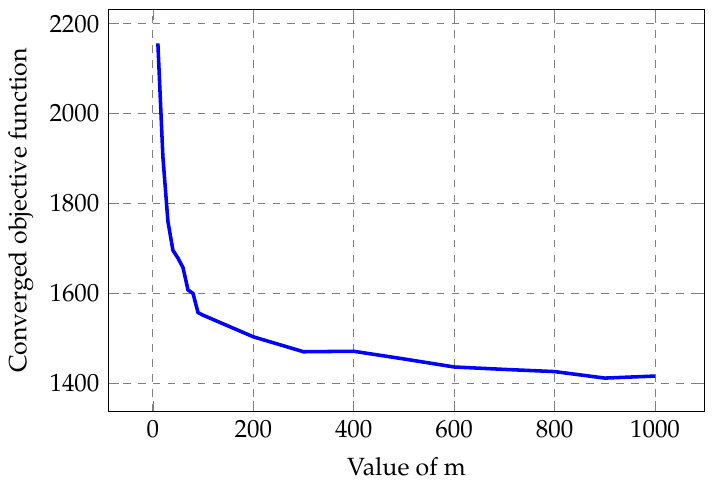
Figure 10. SA converged objective function value versus value of m for the heat conduction problem with a 0.5-volume fraction ( m is the number of objective function evaluations to reach thermal equilibrium in a specific temperature).